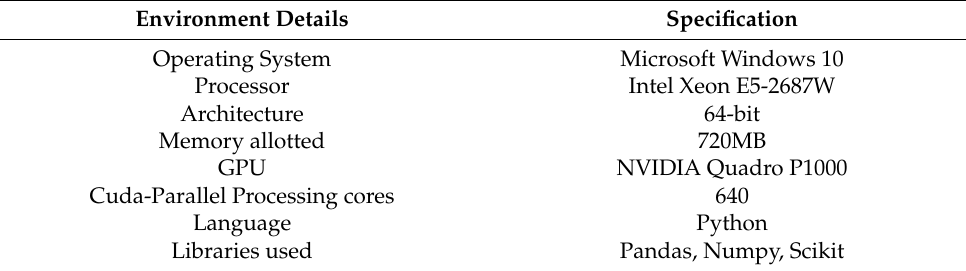
Table 5. Information about the implementation